Question: What kind of plot is shown here?
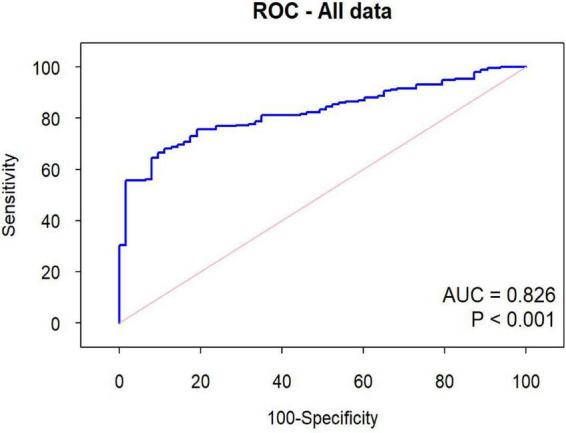
Answer: line